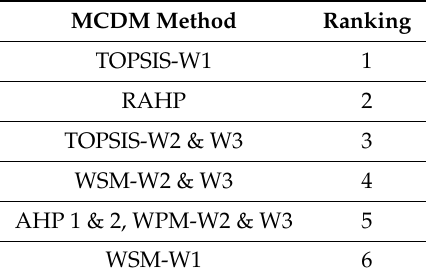
Table 17. Ranking of MCDM methods used based on